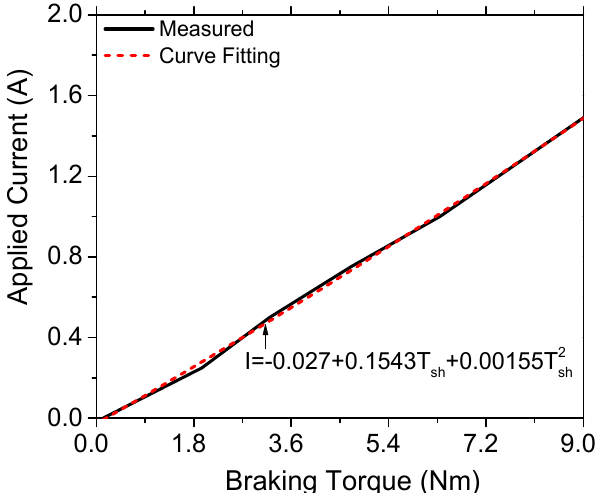
Figure 19. Applied current of the shoulder MR brake as a function of torque.